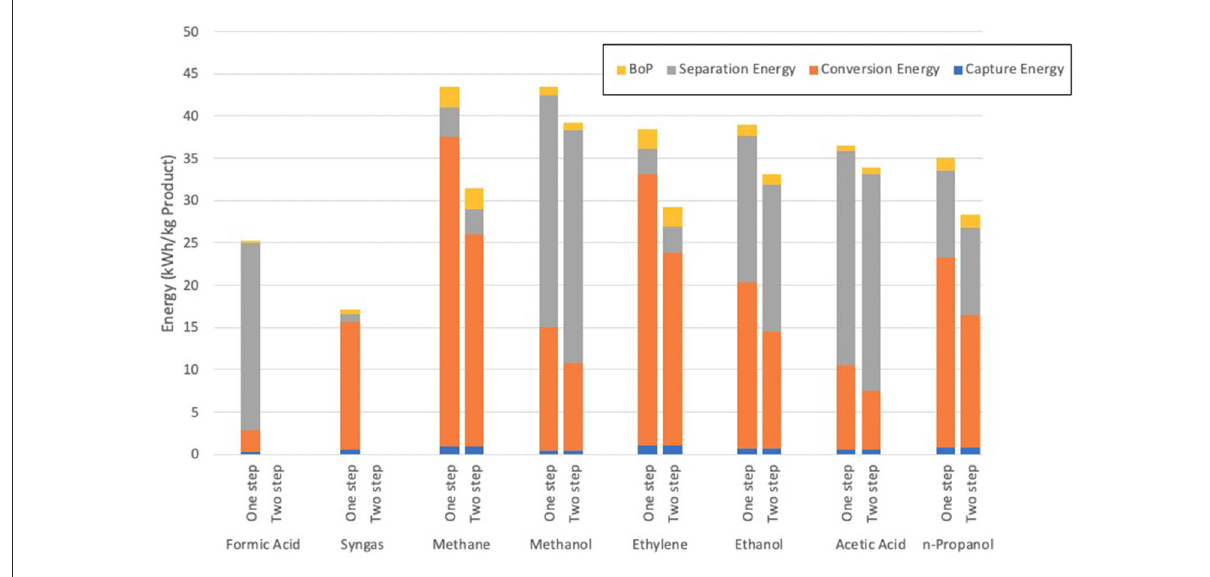
FIGURE10 The required energy for the production of chemicals from the electrochemical reduction of CO 2 (after Kibria Nabil et al.,